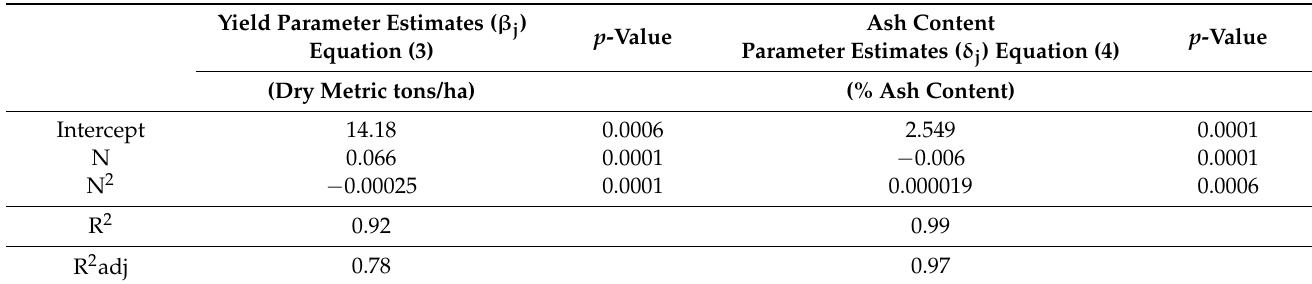
Table 4. MQRF parameter estimates or yield and ash models in Alamo